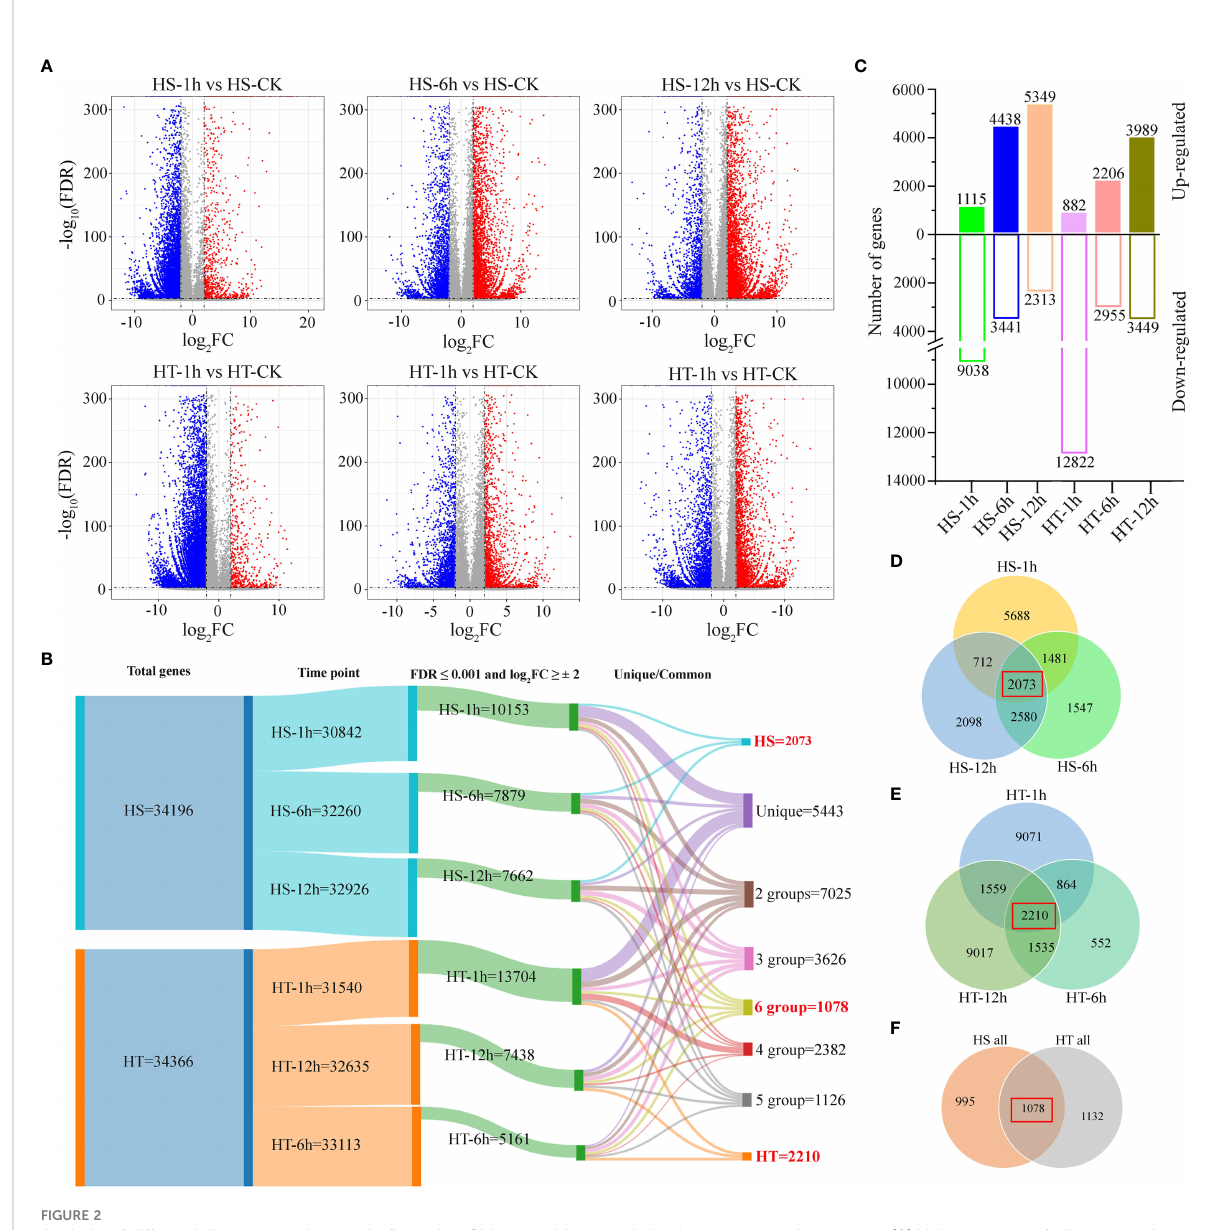
FIGURE 2 Analysis of differentially expressed genes in fl owering Chinese cabbage varieties in response to heat stress. (A) Volcano plots of all expressed genes in heat-sensitive (HS) and heat-tolerant (HT) varieties at different time points relative to CK, with log 2 FC values drawn against – log 10 (FDR) adjusted P- values. Red and blue dots represent up- and down-regulated DEGs based on |log 2 (foldchange)| ≥ 2 and FDR ≤ 0.001; gray dots represent non-signi fi cant DEGs; (B) The Sankey diagram represents the number of common and unique DEGs between each stress point; (C) Number of up and down-regulated DEGs identi fi ed under different heat-stress treatments relative to control HS and HT varieties; (D) Common and unique DEGs under different heat-stress treatments in HS variety; (E) Common and unique DEGs in HT under different heat-stress treatments; (F) Common DEGs in all heat-stress treatments in HS and